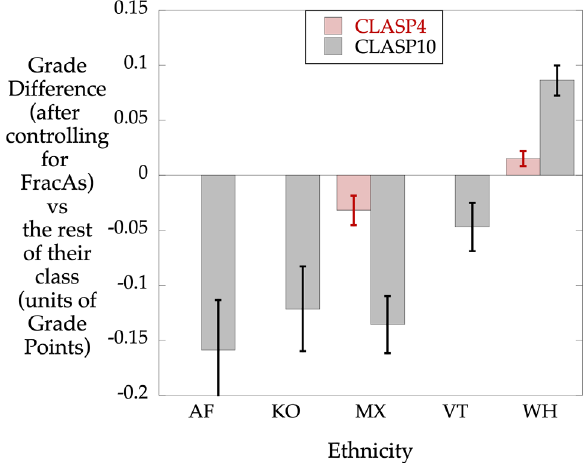
FIG. 2. The grade penalties from Table V that are statistically significant at the P < 0 . 05 level. AF, KO, MX, VT, and WH refer to the group of students with African, Korean, Mexican, Vietnamese, and white (Caucasian), respectively, heritage. A negative value shows that the relevant group had lower grades than their peers in the class after controlling for physics under- standing using their fraction of A grades. The error bars are estimated